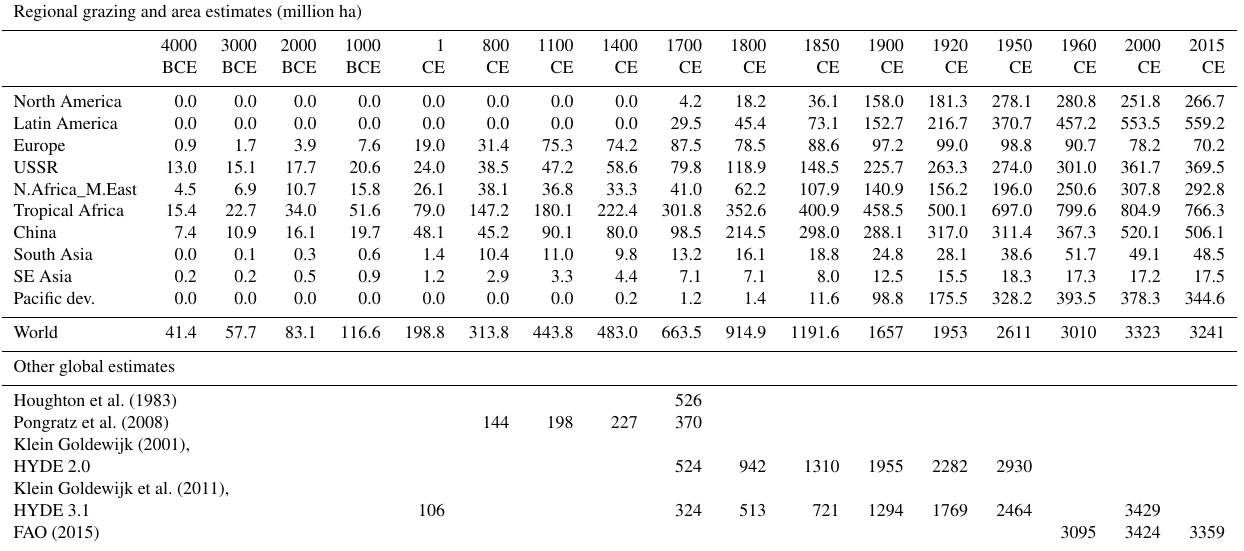
Table 5. Regional grazing land area estimates (million ha). Regional grazing and area estimates (million